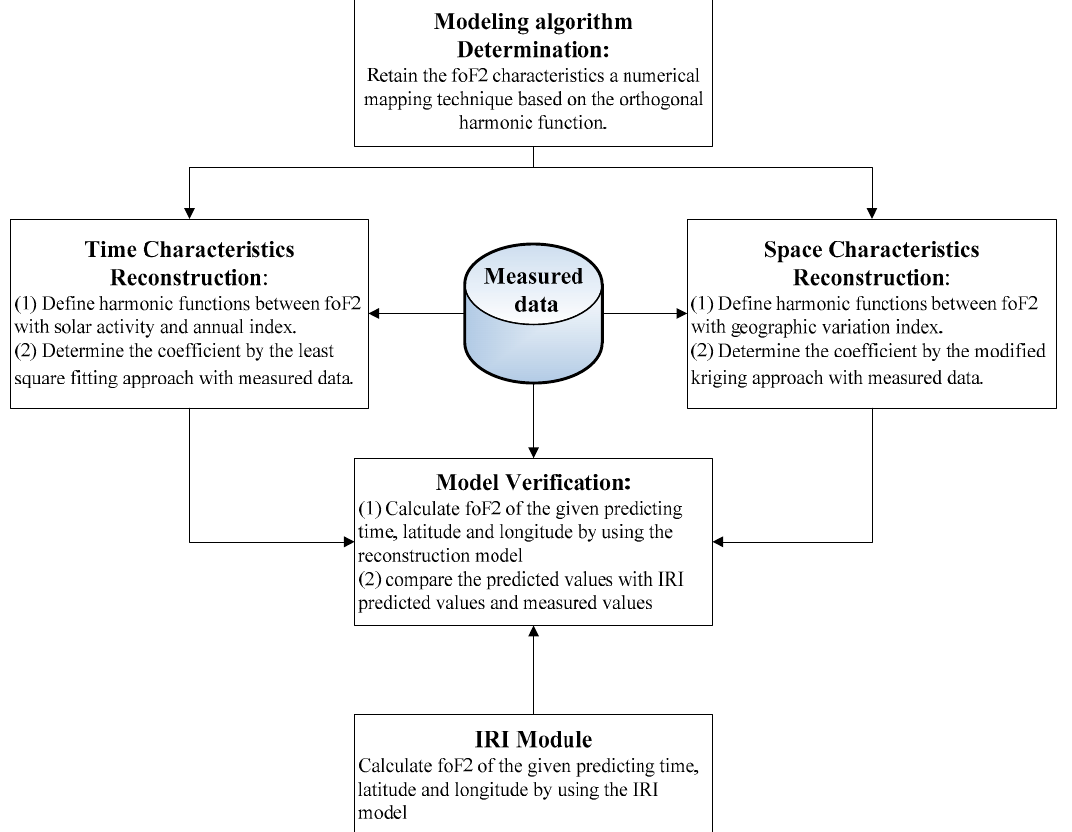
Figure 1. The flow chart of the model reconstruction and verification.